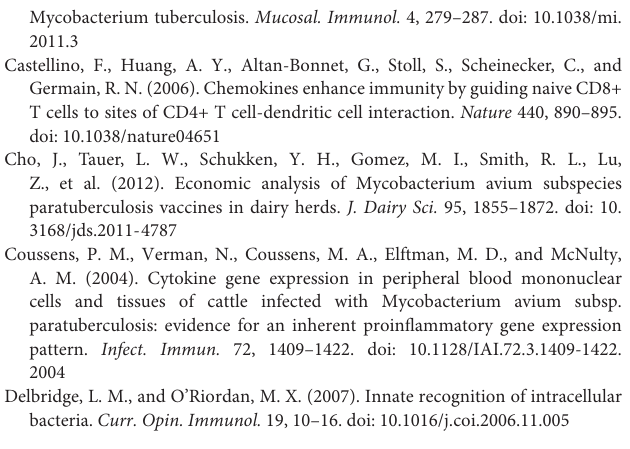
Supplementary Figure 1 | (A) Bovine peripheral blood mononuclear cells sorted by MACS. (B) The result of purity of CD14 + cells. (C) Monocytes that partially produce antennae. Supplementary Table 1 | RT-qPCR primer sequence list. Supplementary Table 2 | Sequencing sequence statistics and quality control results. Supplementary Table 3 | Reference genome comparison statistics. Supplementary Table 4 | Differential mRNA expression results. Supplementary Table 5 | Enrichment and analysis of differentially expressed genes GO. Supplementary Table 6 | Enrichment analysis of differential gene KEGG. Supplementary Table 7 | circRNA differential expression analysis. Supplementary Table 8 | circRNA GO enrichment analysis results table. Supplementary Table 9 | KEGG enrichment analysis results